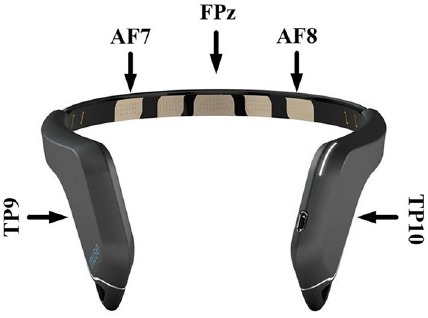
Figure 4. The 2016 Muse EEG system was made by InterAxon Inc with electrodes labelled AF7, AF8, TP9, and TP10. Reference electrode is labelled at